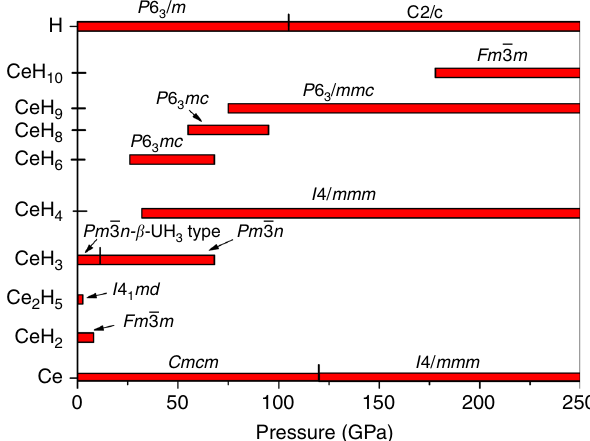
Fig. 5 Pressure – composition phase diagram of theoretically predicted stable phases in the Ce – H system at high pressures. Red horizontal bars show the range of stability of each phase; this phase diagram was created on the basis of the evolutionary structure prediction method USPEX. The experimentally discovered P6 3 /mmc -CeH 9 is predicted to be stable from 78 GPa up to at least 250